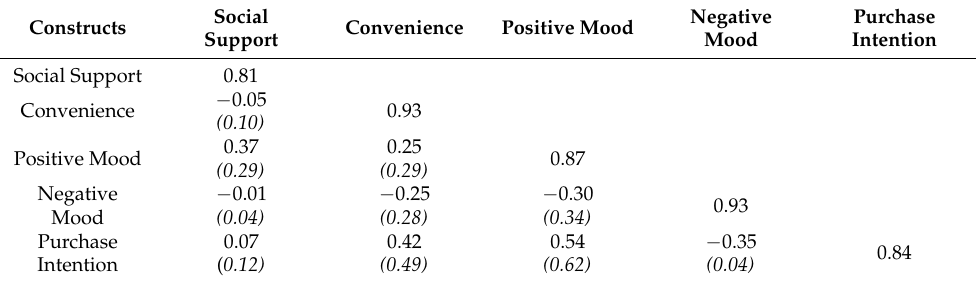
Table 3. Discriminant validity results.